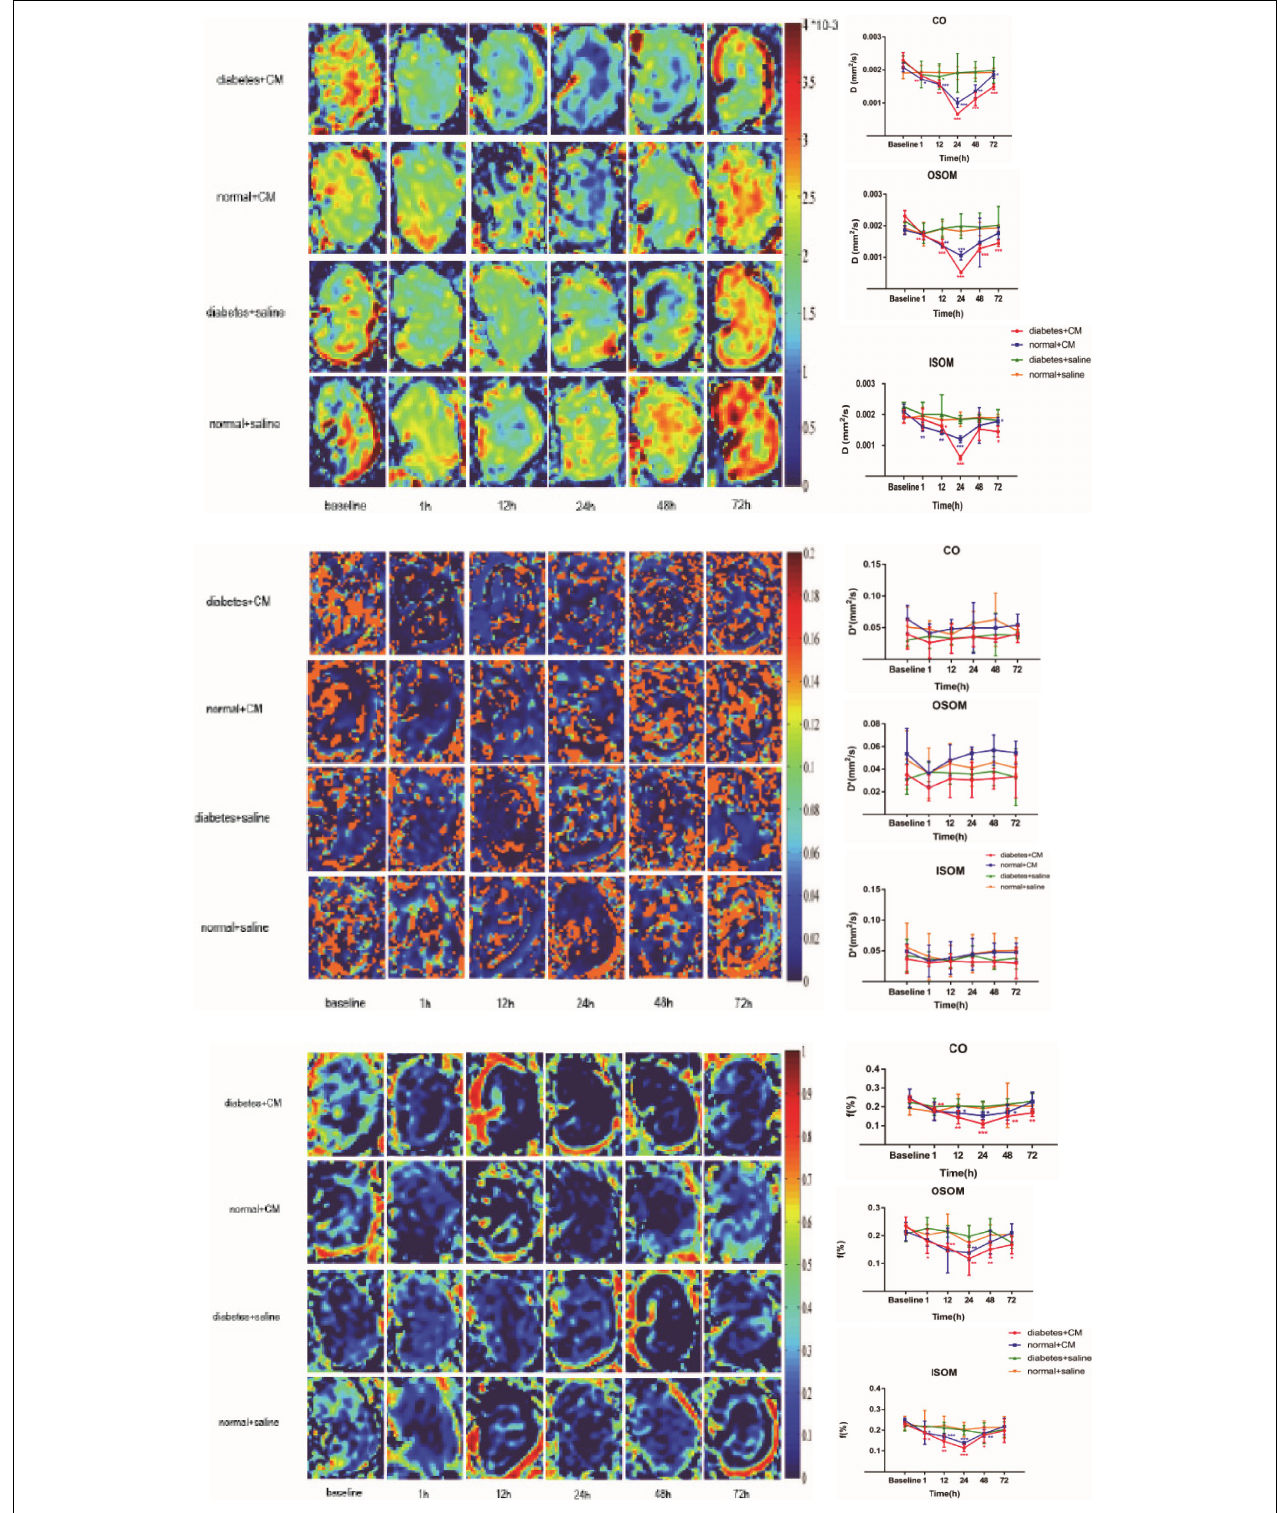
FIGURE 4 | Parametric images of IVIM images. The three clusters of images are the representative D , D *, and f images. Group A diabetes+CM, Group B normal+CM, Group C diabetes+saline, and Group D normal+saline. Compared with baseline, * P < 0.05, ** P < 0.005, *** P < 0.0001. CO, cortex; OSOM, outer stripe of the outer medulla; ISOM, inner stripe of the outer medulla; CM, contrast medium; IVIM, intravoxel incoherent motion.